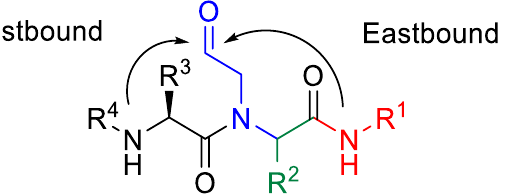
Figure 2. Generic structure of the dipeptide produced by U-4CR with two cyclization